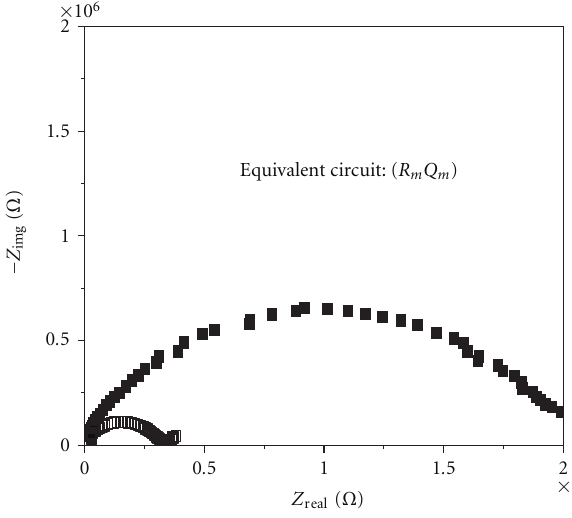
Figure 6: Nyquist plot ( − Z img versus Z real ) and equivalent circuit for Naf-112/DTA + dry sample ( (cid:4) ) and Naf-112/DTA + (w) hydrated sample ( (cid:5) ), that means, after 24 h submerged in distilled